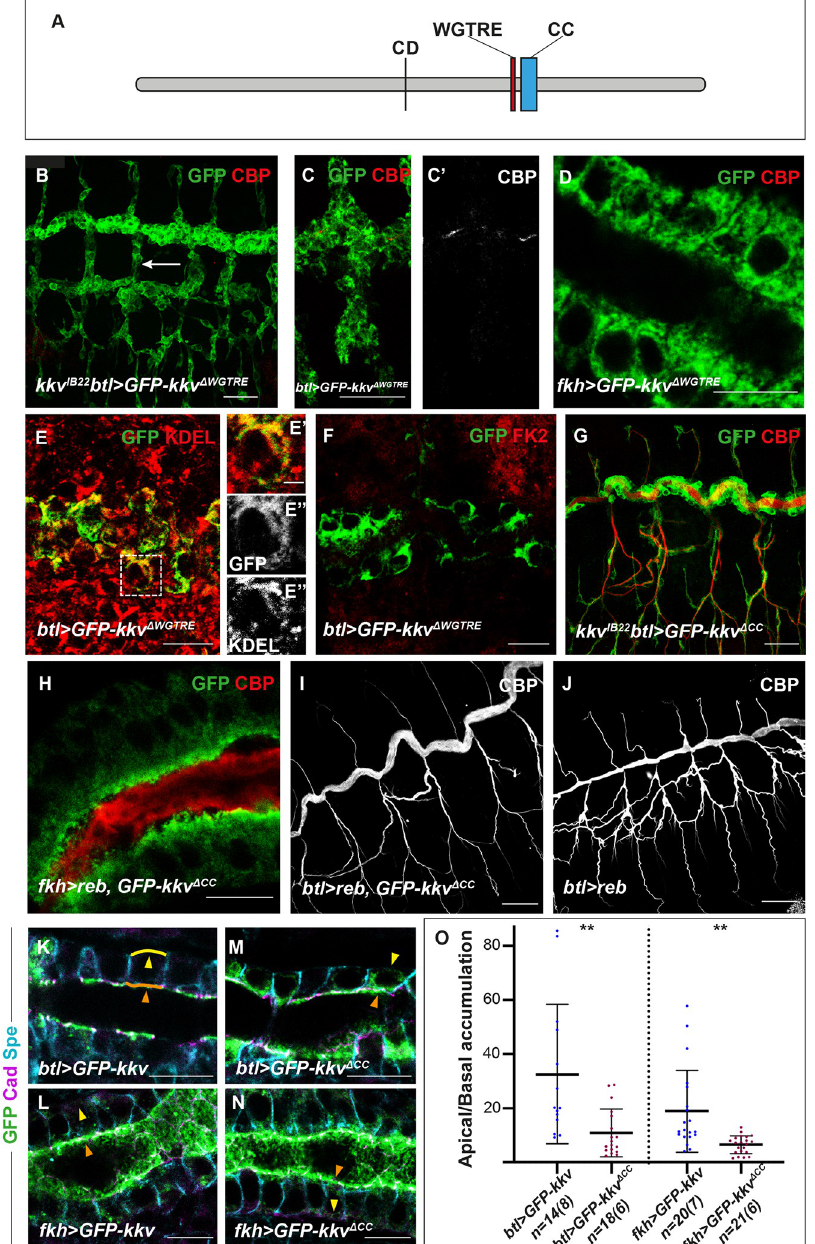
Fig 3. Analysis of the WGTRE and CC domains of Kkv. ( A ) Schematic representation of Kkv protein (CD, catalytic domain; WGTRE; CC, coiled-coil domain). ( B , C , G , I , J ) Show projections of confocal sections and ( D - F , H , K - N ) show single confocal sections. ( B ) The overexpression of GFP-kkv Δ WGTRE in a kkv mutant background does not rescue the absence of extracellular chitin deposition (white arrow, note the absence of CBP) and the protein accumulates in a generalised pattern. ( C - D ) The overexpression of GFP-Kkv Δ WGTRE does not produce intracellular chitin punctae, neither in trachea at early stages ( C - C’ ) nor in salivary glands ( D ). ( E - E”‘ ) GFP-kkv Δ WGTRE colocalise with the ER marker KDEL. ( F ) GFP-Kkv Δ WGTRE does not colocalise with the marker FK2. ( G ) The overexpression of GFP-kkv Δ CC in a kkv mutant background rescues the lack of extracellular chitin deposition in the trachea (note the presence of CBP staining). ( H , I ) The simultaneous expression of reb and GFP-kkv Δ CC in salivary glands produces ectopic extracellular chitin ( H ), and no defects in trachea ( I ). ( J ) The overexpression of reb in trachea leads to morphogenetic defects. ( K , L ) Overexpressed GFP-Kkv localises mainly apically (orange arrowheads) although a bit of the protein can be detected in the basal region (yellow arrowheads). ( M , N ) Apical accumulation of overexpressed GFP-Kkv Δ CC is less conspicuous. ( O ) Quantifications of accumulation of GFP-Kkv and GFP-Kkv Δ CC in apical versus basal region. n corresponds to the